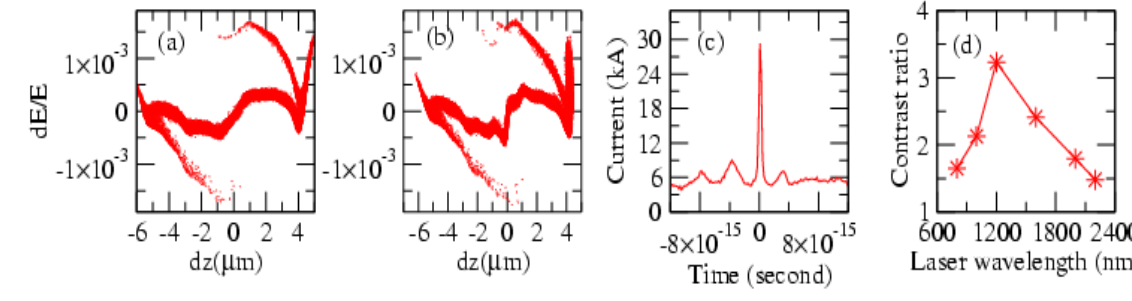
Figure 6. (Color online). ( a ) The longitudinal energy distribution of the electron bunch before the wiggler. ( b ) The longitudinal energy distribution after chicane. ( c ) The electron bunch current profile after chicane for λ = 1,200 nm and τ (FWHM) = 7.5 fs. ( d ) The L change of contrast ratio with respect to laser wavelength